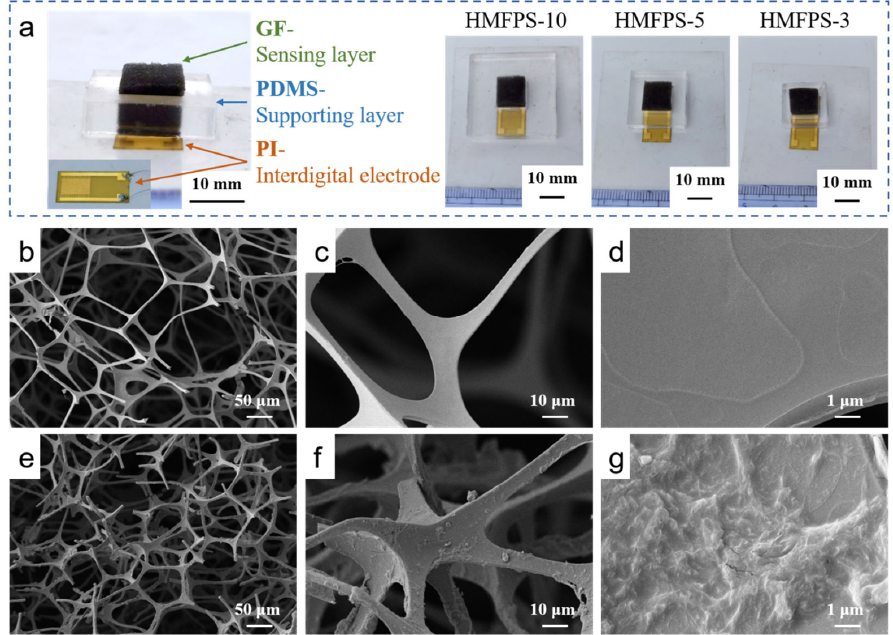
Figure 2. ( a ) Photographs of the HMFPS-3, HMFPS-5 and HMFPS-10; SEM images of ( b – d ) the MF and ( e – g ) the GF.